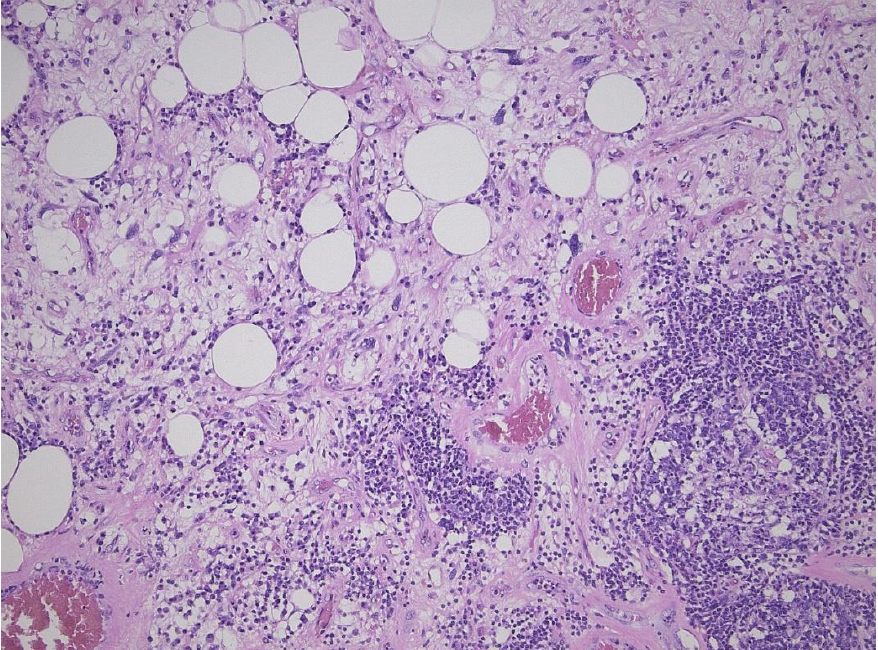
Figure 3. Inflammatory variant of well-differentiated liposarcoma/atypical lipomatous tumor, dominated by a prominent lymphoplasmocytic infiltration. Note the atypical fat cells as well.